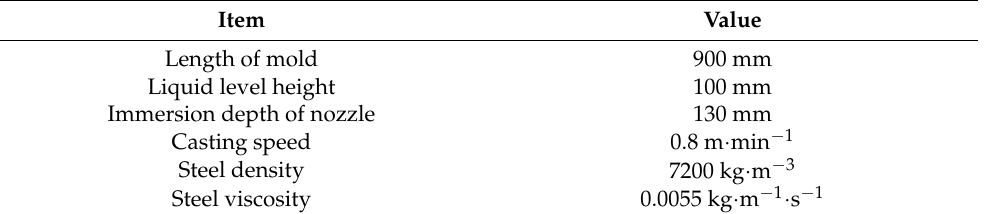
Table 1. Calculation parameters.